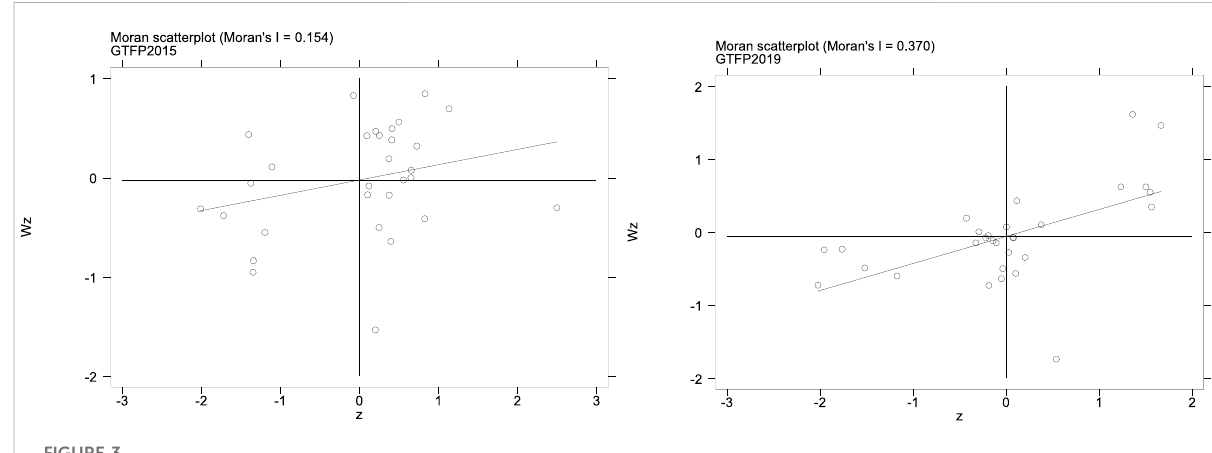
FIGURE 3 Moran ’ s I scatter plots of green total factor productivity in 2015 and 2019 for the 30 provinces.